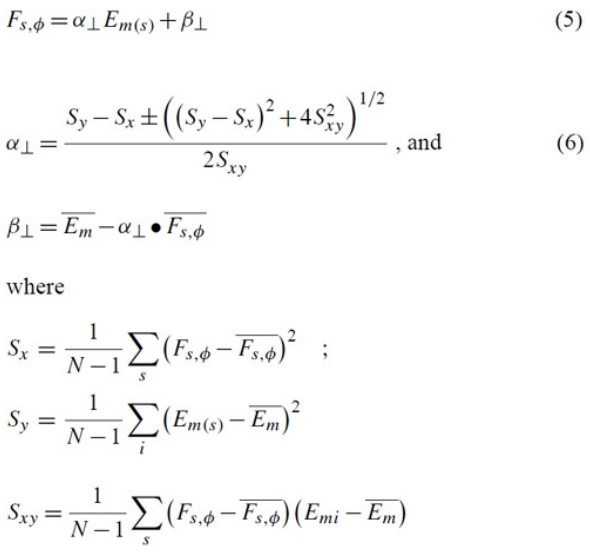
Fig. 3*. Set of defining orthogonal regression equations from Mc- Creadie and Menvielle